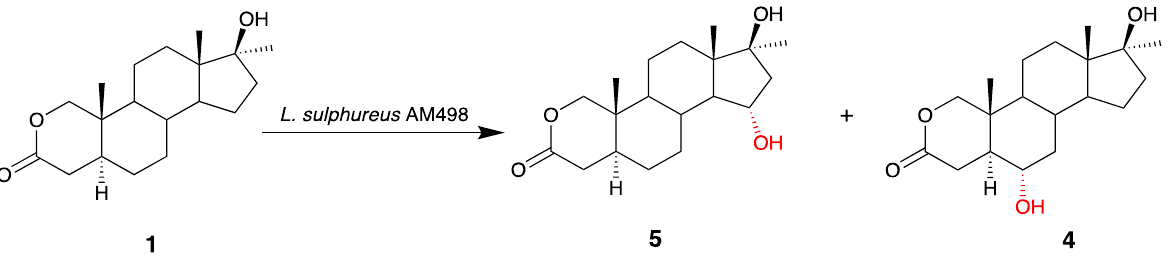
Figure 3. Transformation of oxandrolone ( 1 ) in the culture of Laetiporus sulphureus AM498.